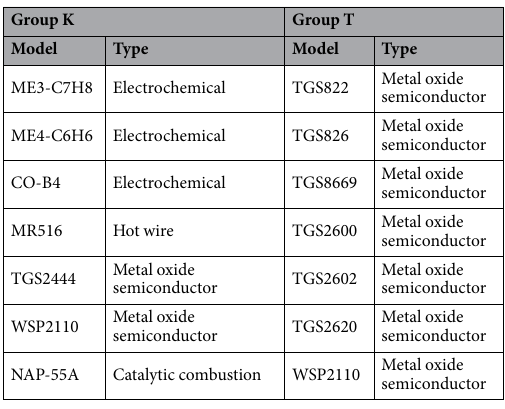
Table 5. Sensors